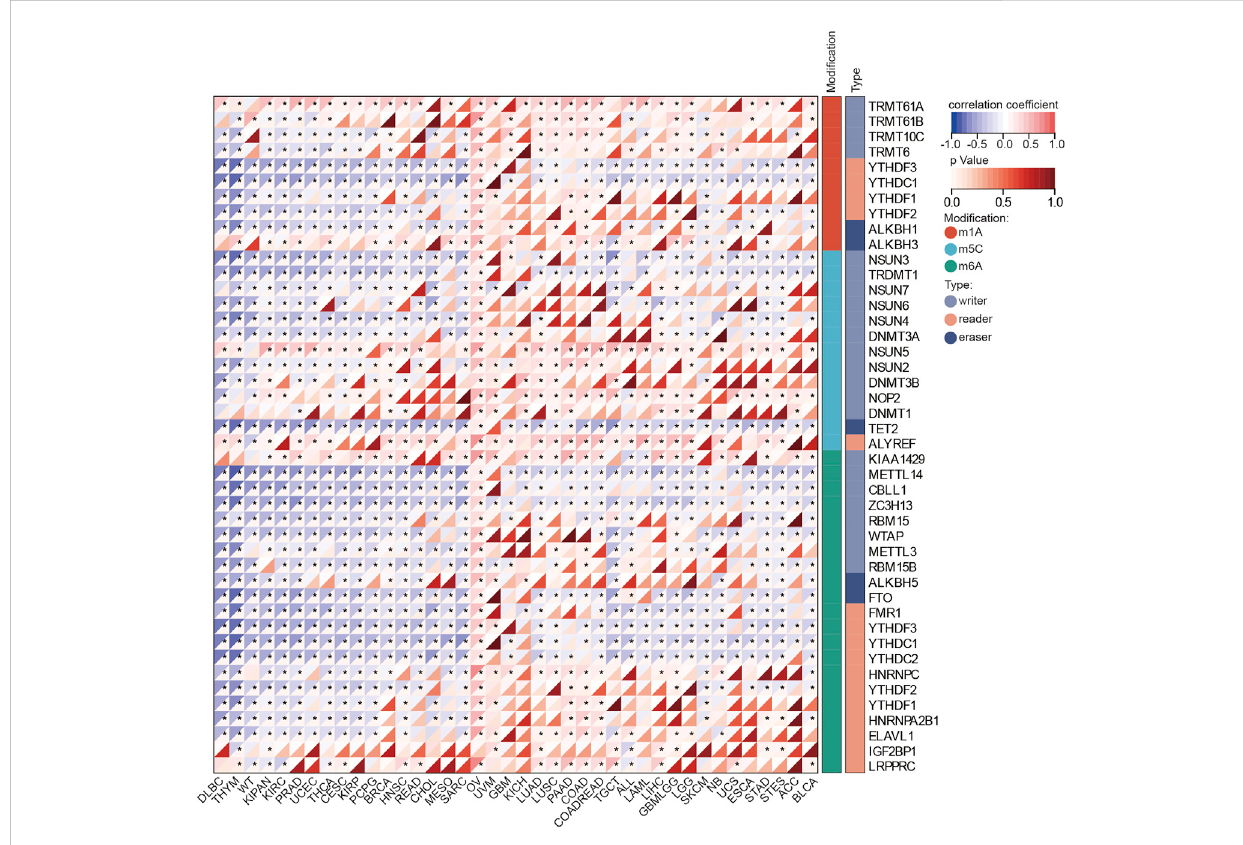
Heatmaps of BOLA2B correlation with mRNA modi fi cation. The color depth in the heatmap represented correlation coef fi cients of BOLA2B and mRNA modi fi cation markers. * p < 0.05, ** p < 0.01, and *** p <